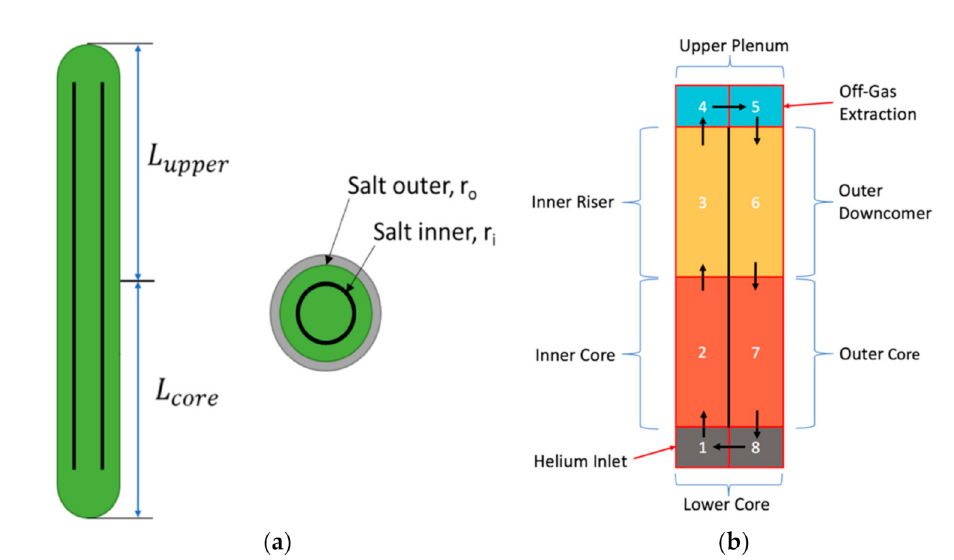
Figure 2. ( a ) Simple layout of VESIL; ( b ) CTF VESIL representation.